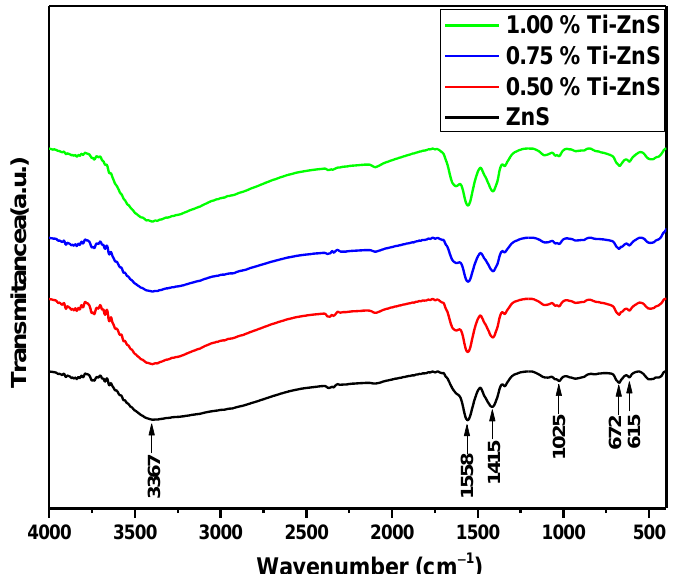
Figure 4. FTIR spectra of undoped ZnS and Ti-doped ZnS nanopowder samples at different concen- trations.